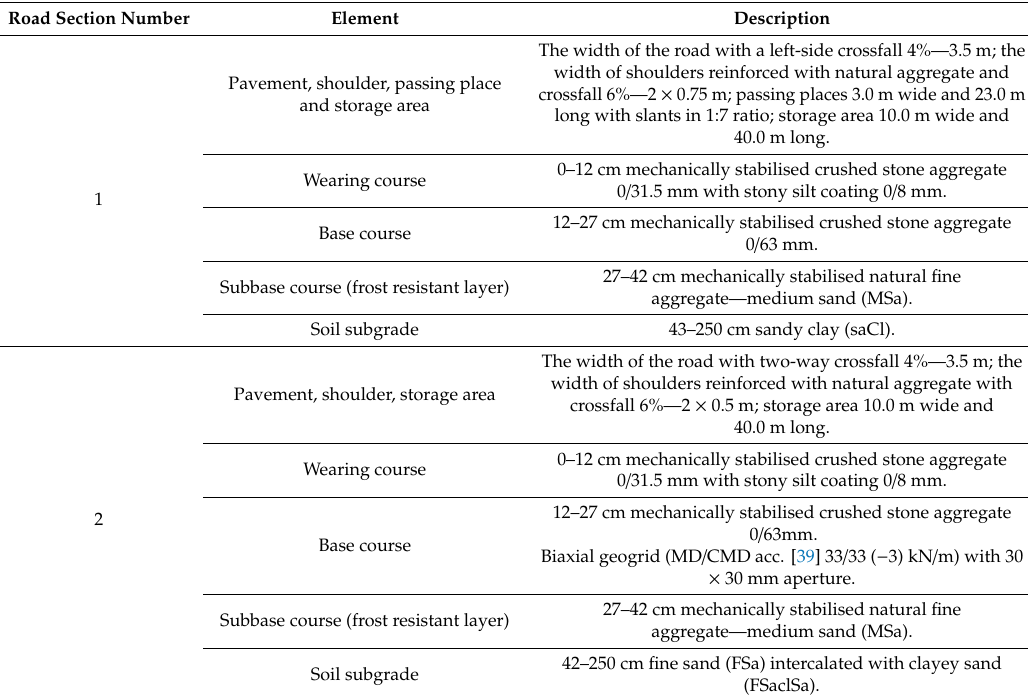
Table 1. Description of the studied experimental road sections.